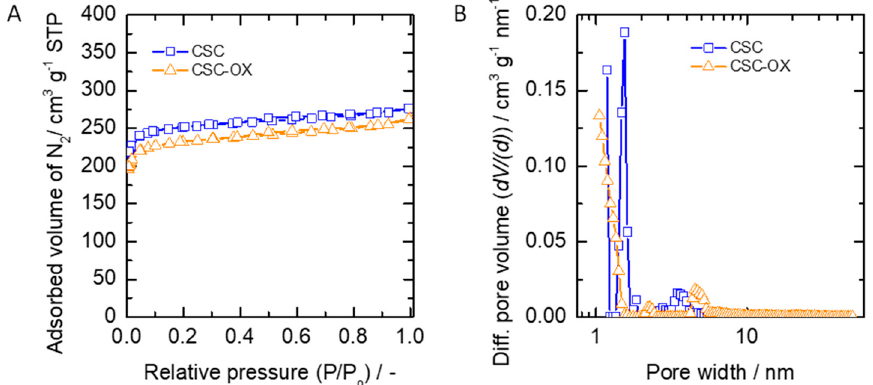
Figure 1. ( A ) N 2 -sorption isotherm sorption. ( B ) The pore size distribution of carbon evaluated by